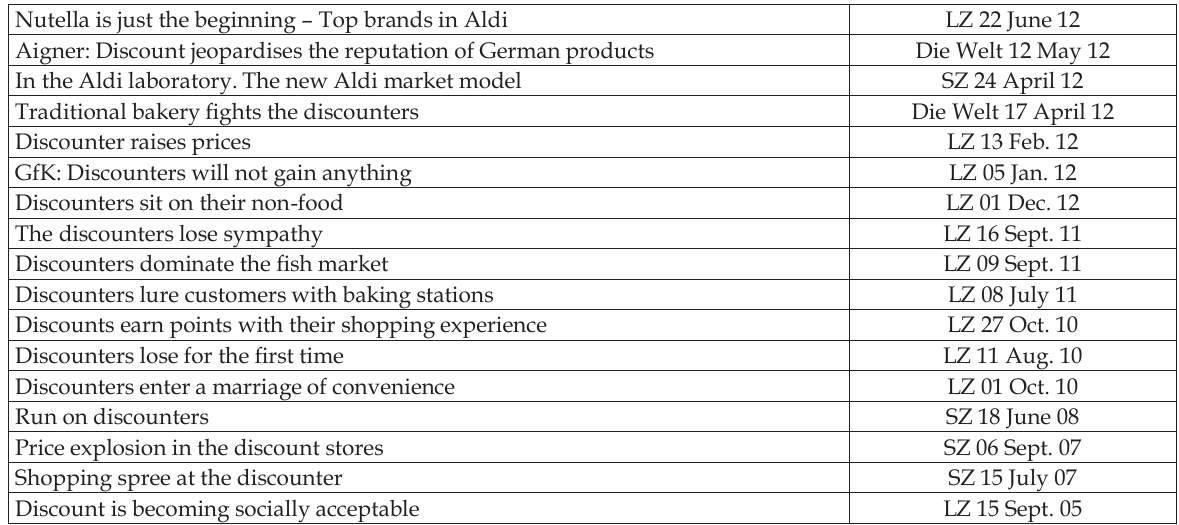
Table 1. Grocery discounters in the news (specialty and local media).